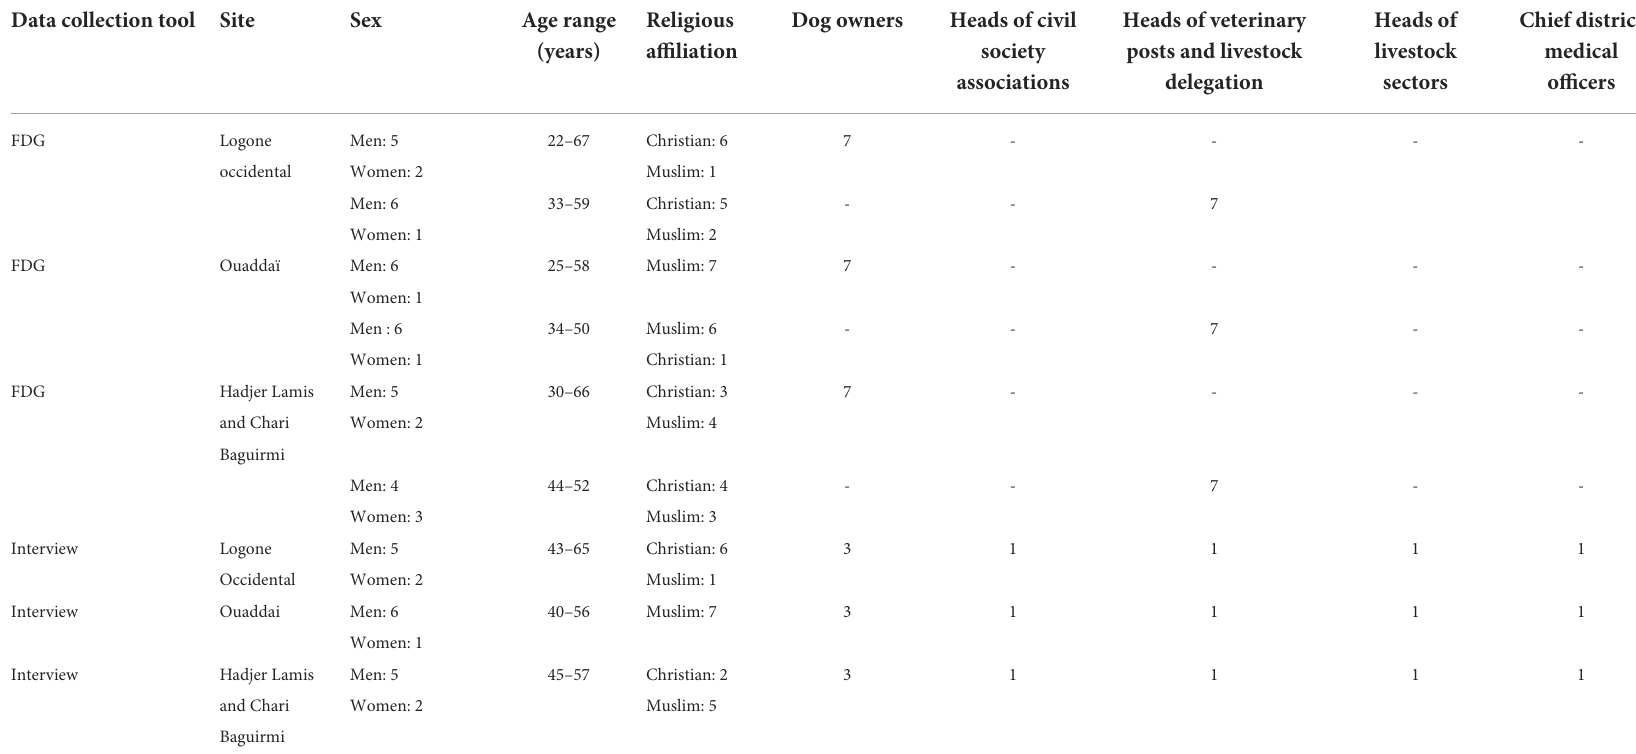
TABLE 1 Socio-demographic characteristics of research participants. Data collection tool